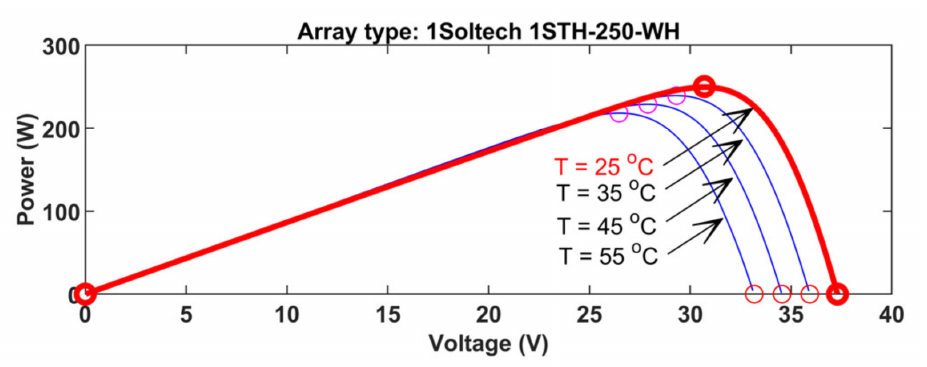
Figure 2. P-V curve for different temperatures at 1000 W/m 2